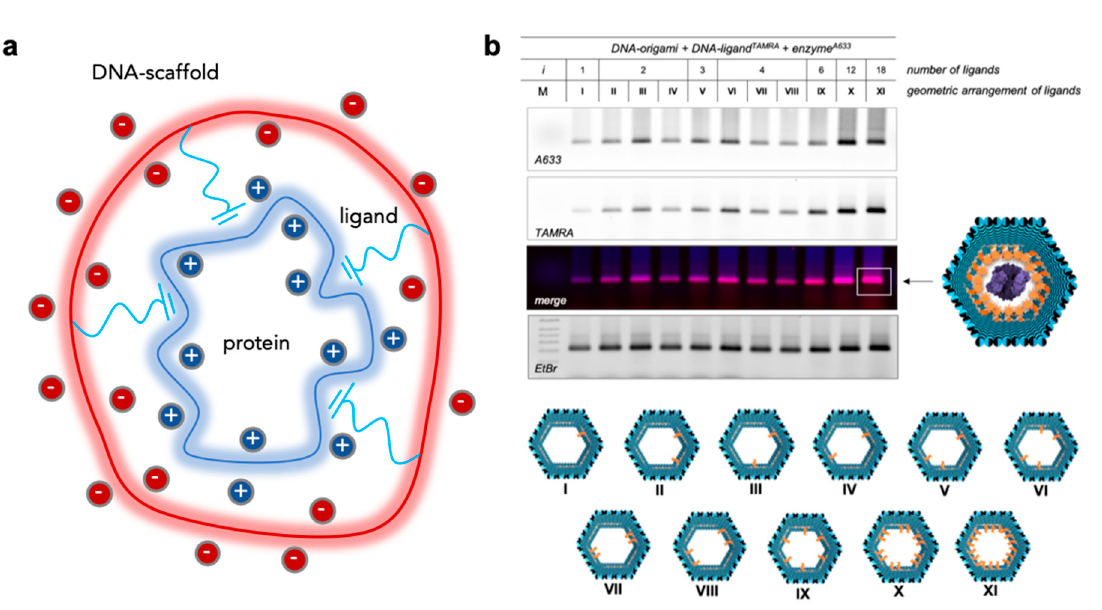
Figure 5. Multivalency in DNA-protein nanoconstructs. ( a ) A multivalent system composed of n identical ligands anchored to the same DNA scaffold and pre-oriented towards the corresponding m binding sites exposed on the surface of the protein receptor. The system can be analyzed with the Kitov and Bundle model enabling to extract the contribution given by the degeneracy of the system. ( b ) Agarose gel electrophoresis characterization of the non-covalent binding of a hexameric protease enzyme (DegP 6 ) within the cavity of a DNA origami structure bearing distinct numbers of peptide ligands (1 < i < 18) in different geometric arrangements (I-XI, bottom panel). Adapted with permission from Reference [47] © 2017 Macmillan Publishers Ltd.